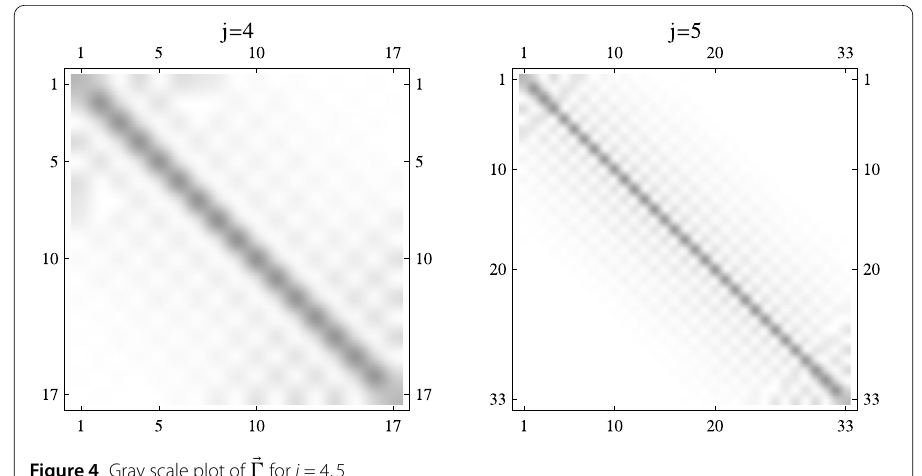
Figure 4 Gray scale plot of (cid:9) (cid:17) for j =